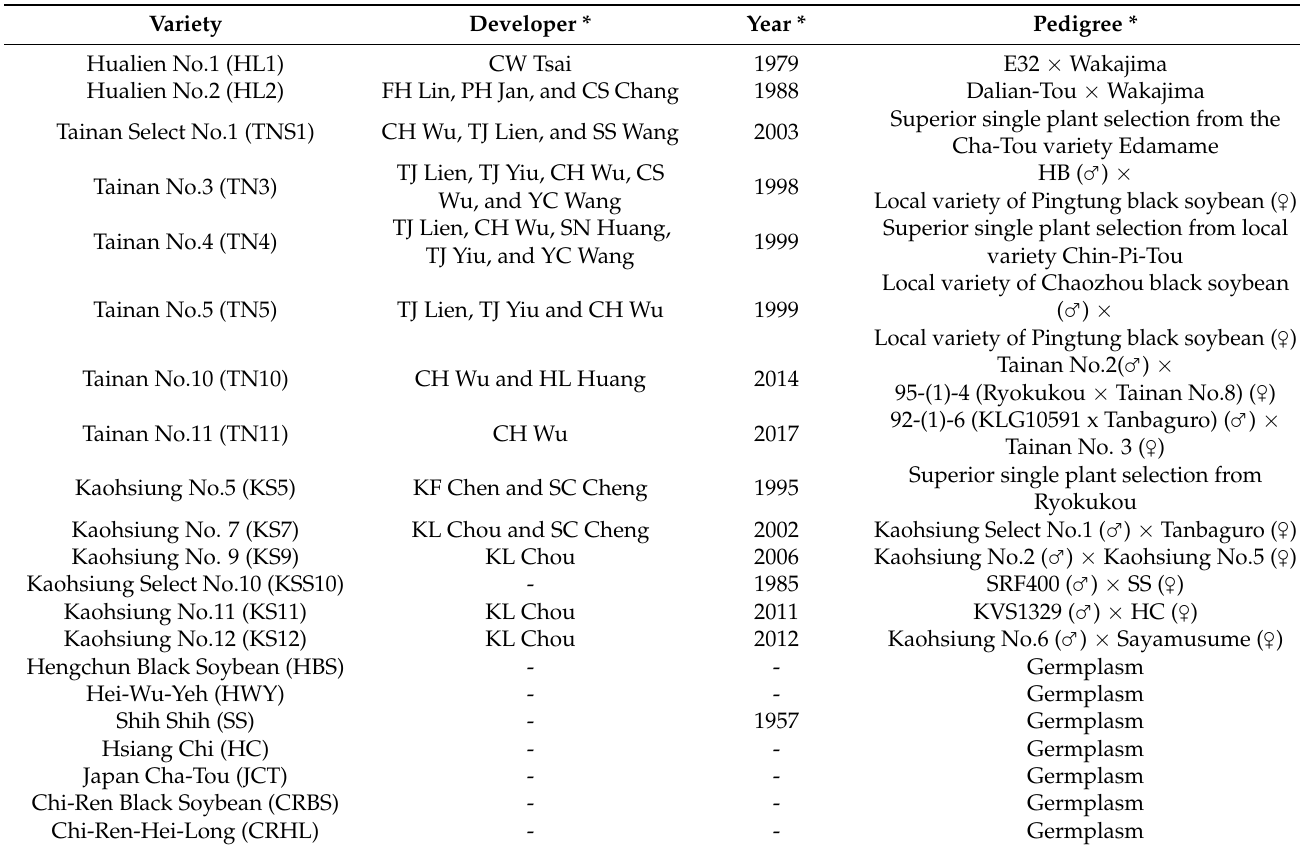
Table 1. Twenty-one soybean varieties of Taiwan tested in this